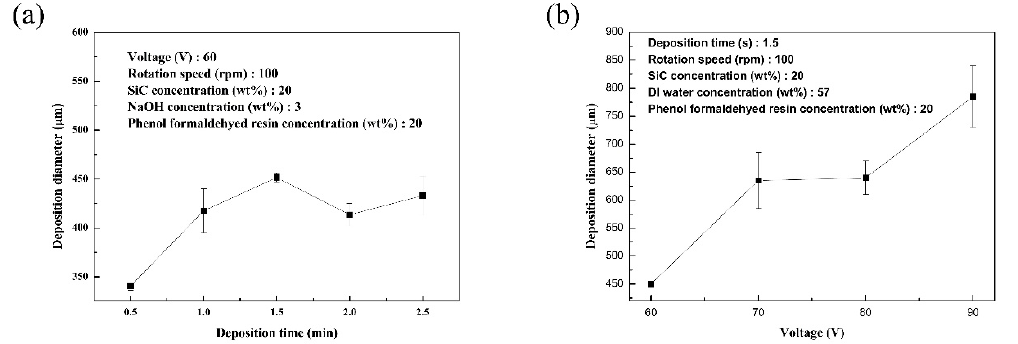
Figure 12. The relation between ( a ) the deposition time and deposition diameter. ( b ) The voltage and deposition diameter. deposition